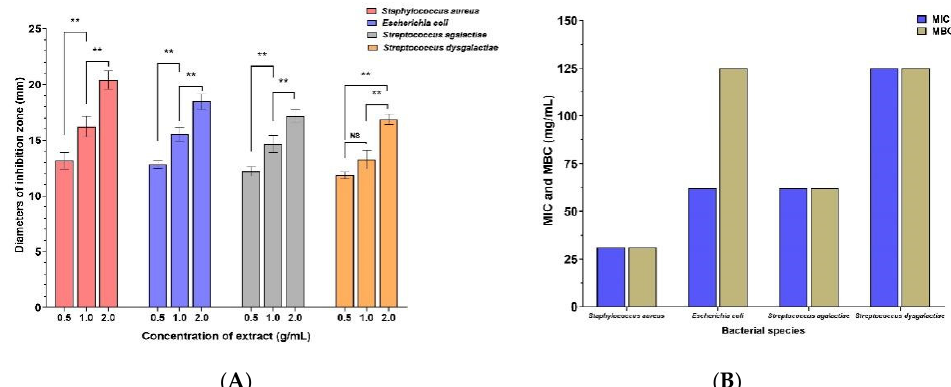
Figure 2. Bactericidal and antibacterial activities of HHPJE. ( A ) MIC of HHPJE on Staphylococcus aureus , Escherichia coli , Streptococcus agalactiae and Streptococcus dysgalactiae . ( B ) MBC of HHPJE on 4 strains. Values were expressed as the mean ± SD, and all data were analyzed using one-way ANOVA followed by multiple comparisons. ** represents extremely significantly different between two groups ( p < 0.01), while NS means no significant differences ( p > 0.05).